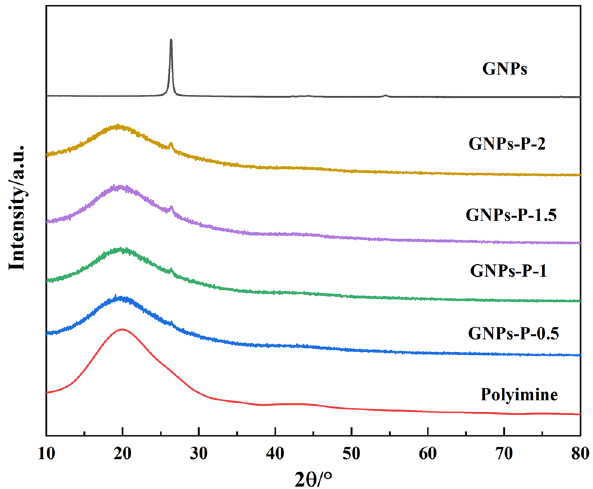
Figure 2: The X - ray di ff raction patterns of polyimine, GNPs, and di ff erent GNPs - P